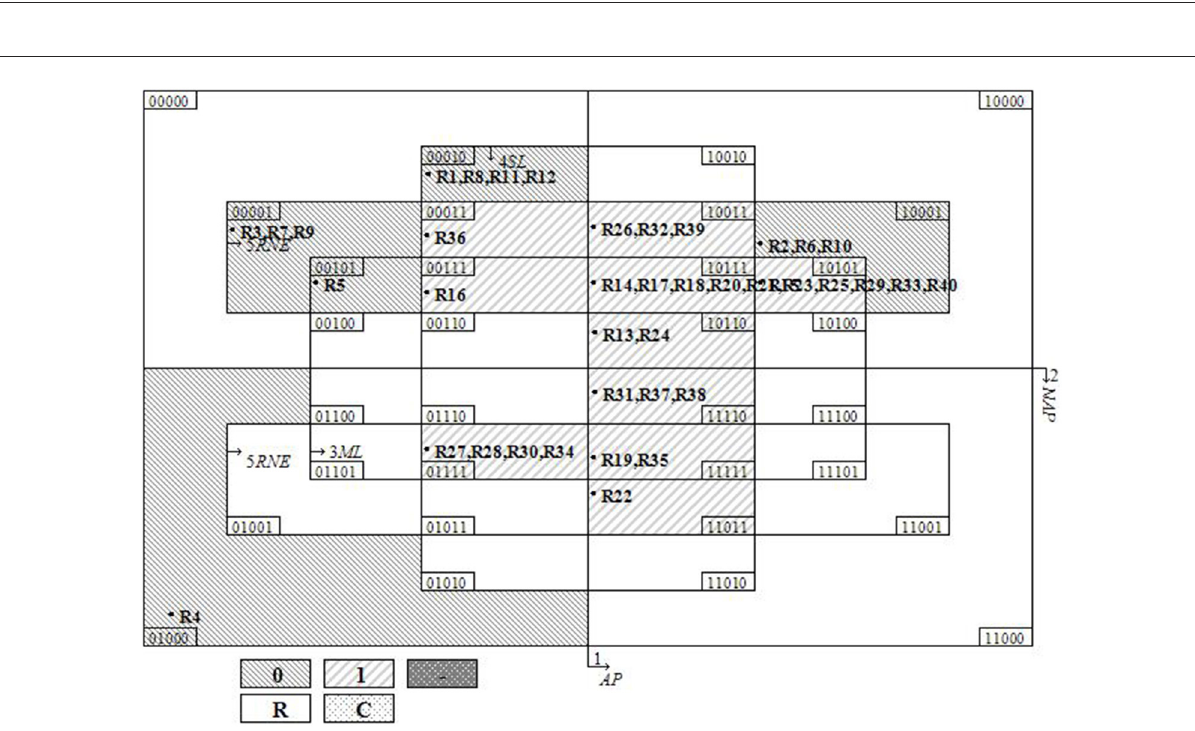
FIGURE3 Visualization of truth tables after threshold adjustment. Data source: The result of this figure is reported by the Visualize function of Tosmana. “0” means that the result does not occur, “1” means that the result occurs, “R” means Logical remainders, and “C” means Contradictory